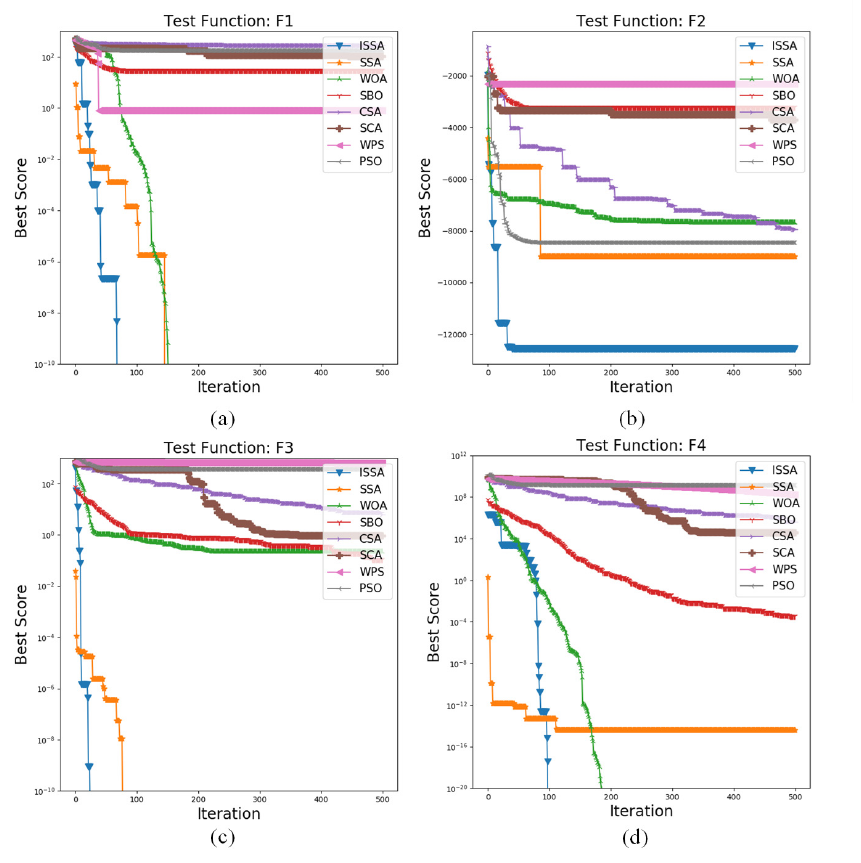
Figure 9. Convergence curves of different algorithms on test